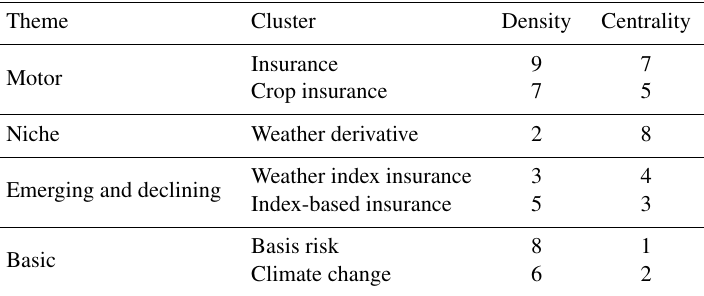
Table 1. Thematic mapping of the documents based on the conceptual structure of the authors’ keywords divided into seven clusters with word frequency higher than 40 words according to centrality (the relevance of the theme in the development of the field) and density (the development of the